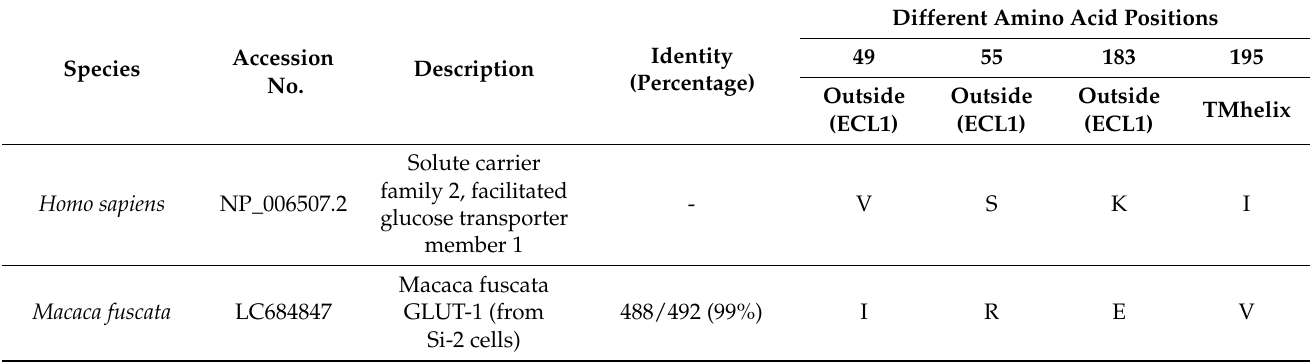
Table 1. Amino acid sequence identity between human GLUT1 and Japanese macaque GLUT1.